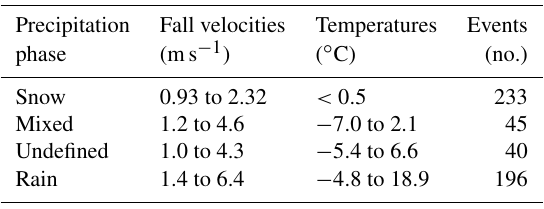
Table 2. Mean fall velocities and temperatures of precipitation events by type classification.